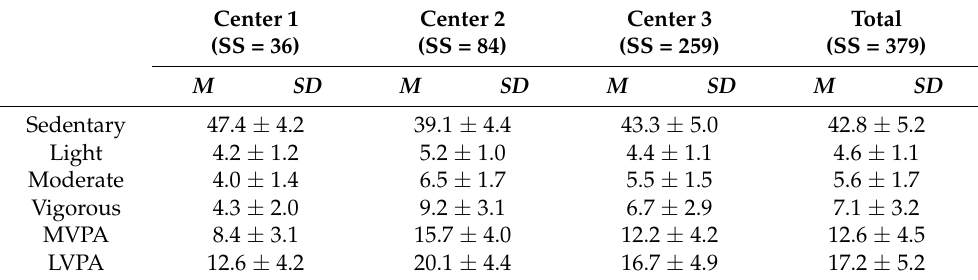
Table 5. Minutes recorded of PA performed in the specific motor sessions.